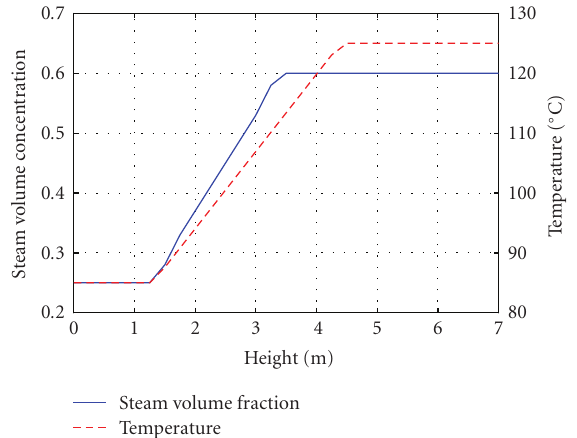
Figure 7: Pressure evolution with decreased steam volume fraction at low